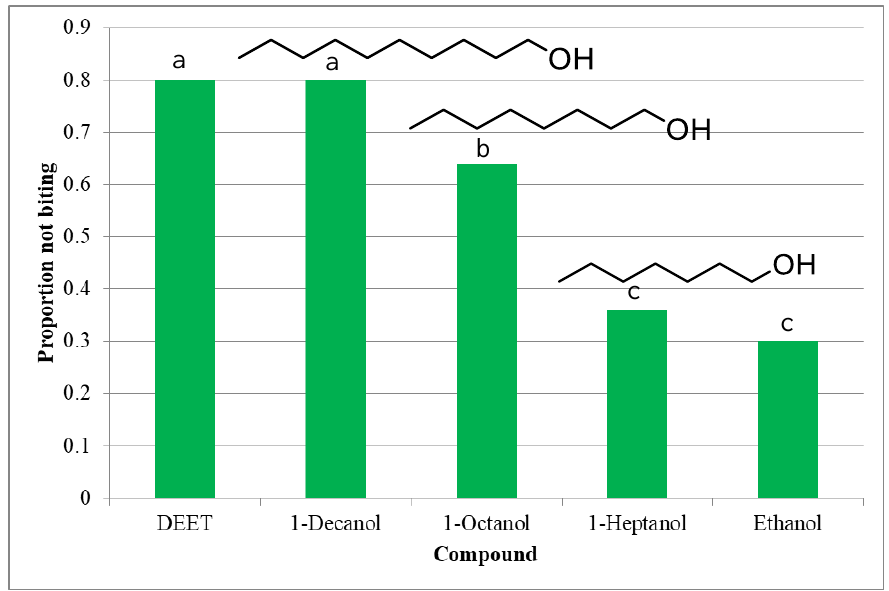
Figure 2. Mean proportion not biting values of the essential oils from di ff erent parts of M. grandiflora against Ae. aegypti . Essential oils were tested at 10 µ g / cm 2 while DEET at 25 nmol / cm 2 was tested as a positive control. Mean proportions sharing the same letter are not significantly di ff